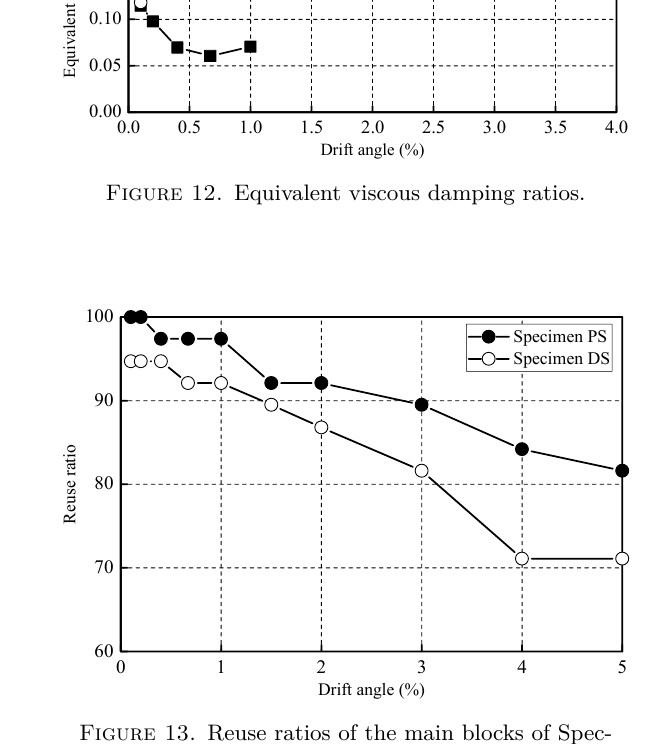
Figure 11. Lateral load P due to rocking mechanism.